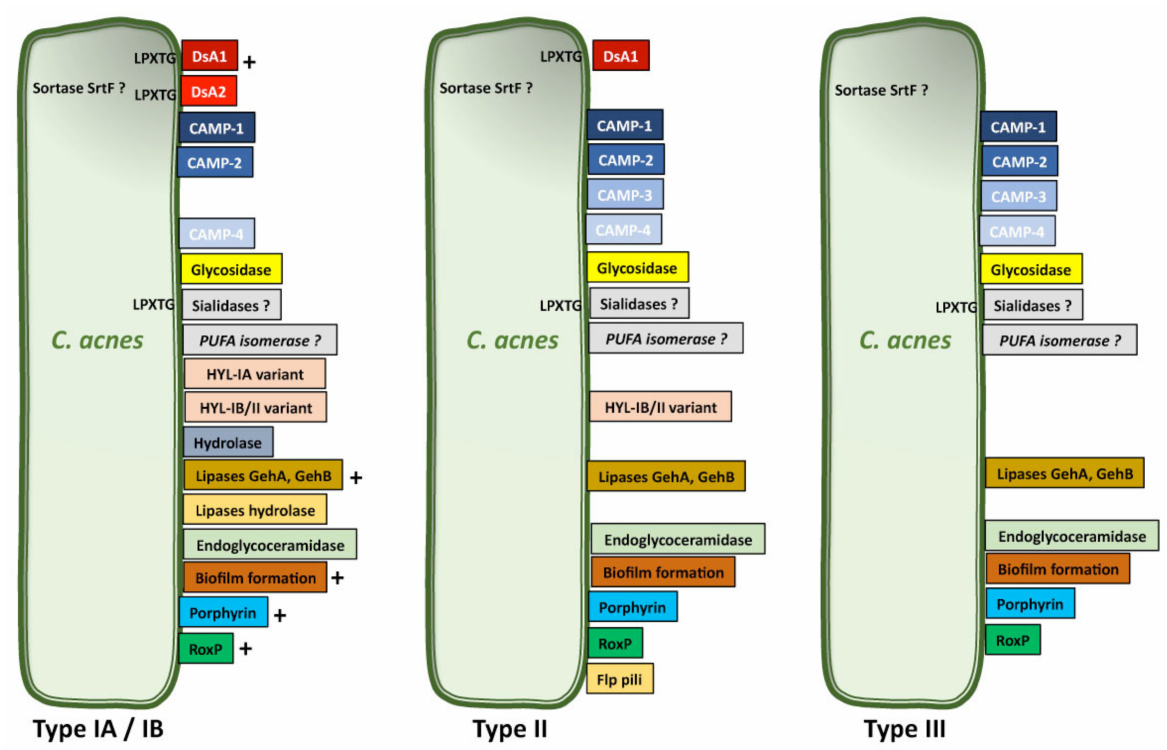
Figure 3. Differential expression of virulence factor by C. acnes . Non-exhaustive representation of secreted and/or cell-wall anchored protein. Regarding HylA enzymes, we added both variants and a comment in the figure legend: HYL correspond to the hyaluronate lyase with the HYL-IB/II variant exhibiting a high level of activity and the HYL-IA variant with a lower level of activity. LPXTG correspond to the peptidic sequence recognized by sortase. (+) correspond to highly expressed. (?) the presence in the phylotype is not yet determined. References sources: